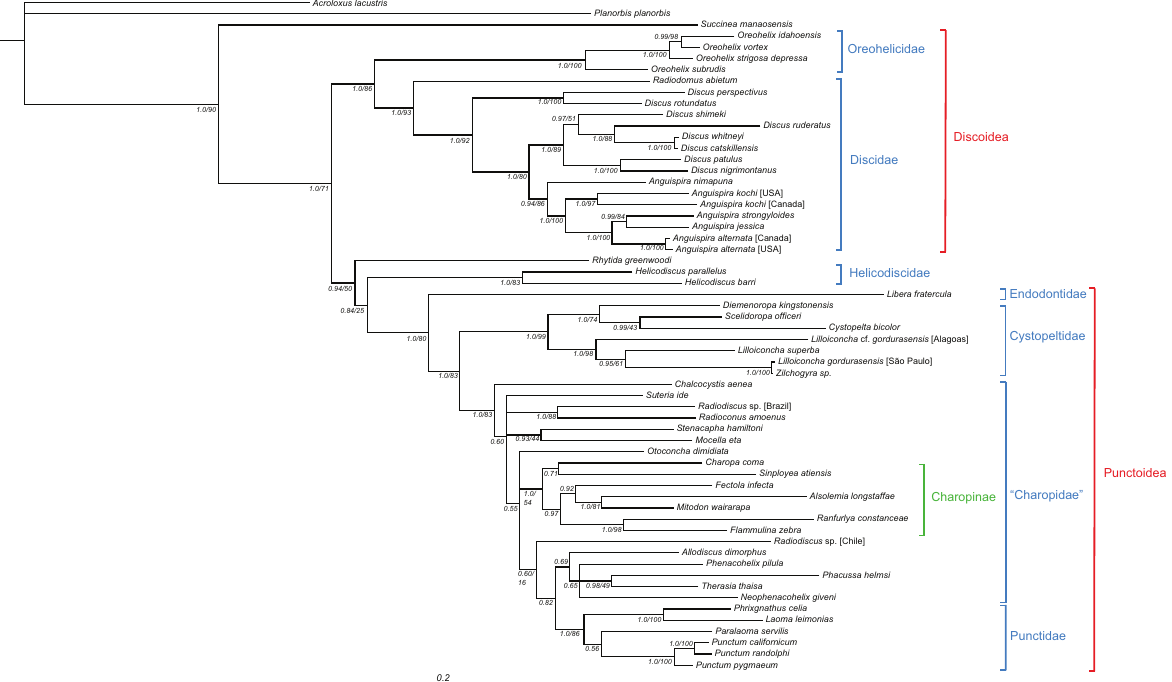
Figure 1. Bayesian tree for the “Punctoidea”, rooted by the Hygrophila. Numbers shown on nodes are BI posterior probabilities (0 to 1) followed by ML bootstrap values (0 to 100%). Scale bar is substitutions per site.